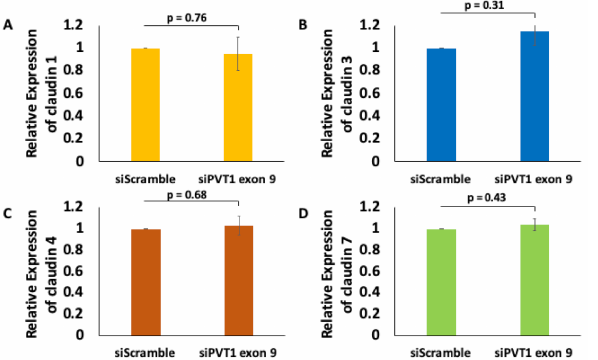
Figure 5. PVT1 exon 9 does not regulate mRNA expression of claudins 1, 3, 4, and 7 in MDA MB 231 cells. Claudin 1 ( A ), claudin 3 ( B ), claudin 4 ( C ) and claudin 7 ( D ) mRNA expression were assessed